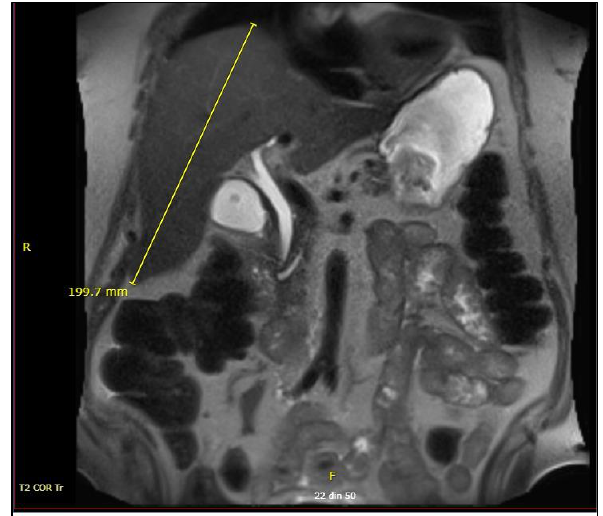
Figure 1. Computed tomography (CT) of the abdomen; R—Right; F—Frontal